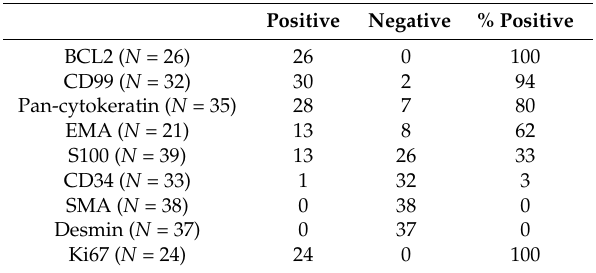
Table 1. Immunostaining characteristics from 43 cases of early-stage and stage IV synovial sarcoma between 2006 and 2014.